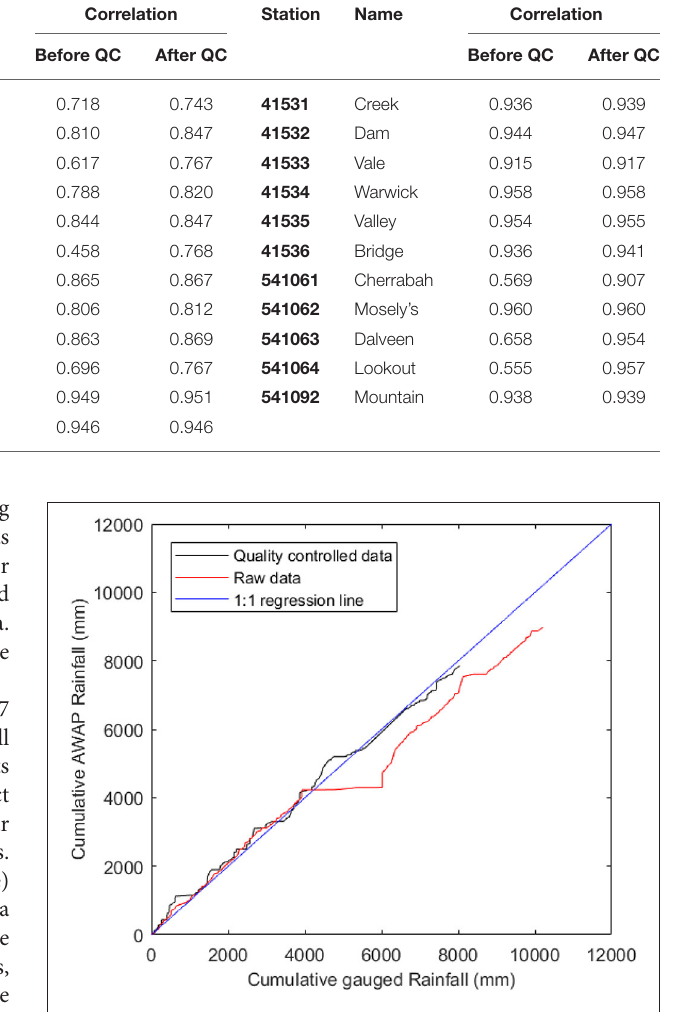
FIGURE 2 | Double-mass plot of cumulative AWAP reference rainfall against rain gauge 540207 both before and after applying quality control.